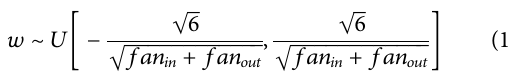
TABLE 1 | Technical speci fi cations of the DKASC power